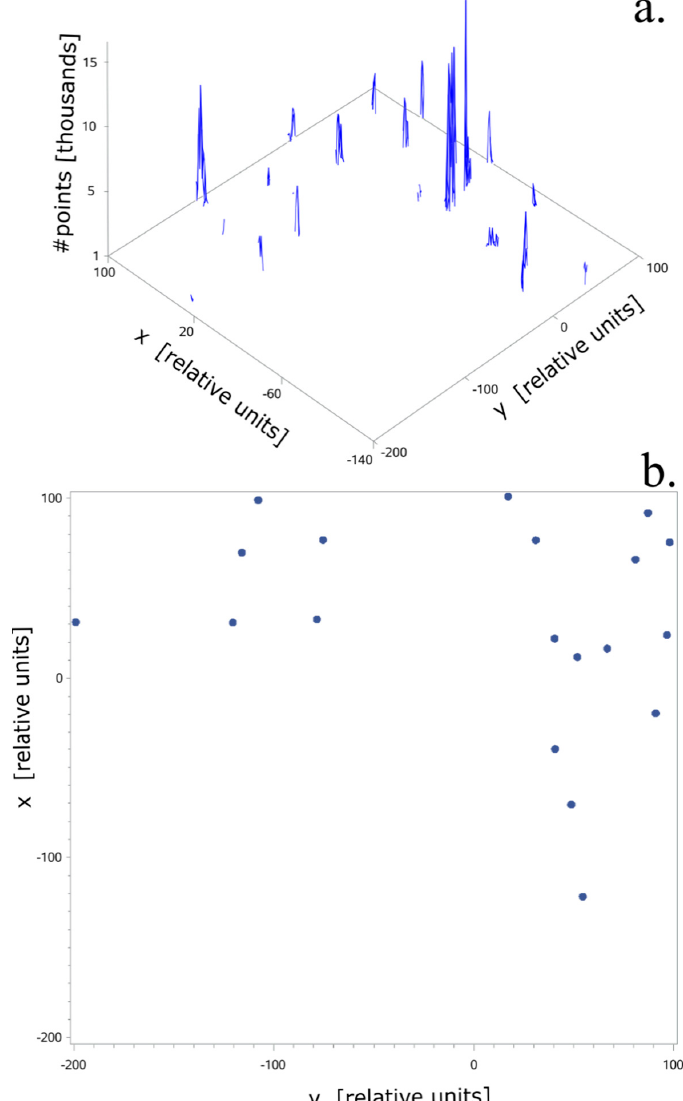
Figure 7. Estimation of the relative location of the stems from the point clouds from Figure 6. ( a ) number of points from the filtered PPC, ( b ) relative location of the trees.